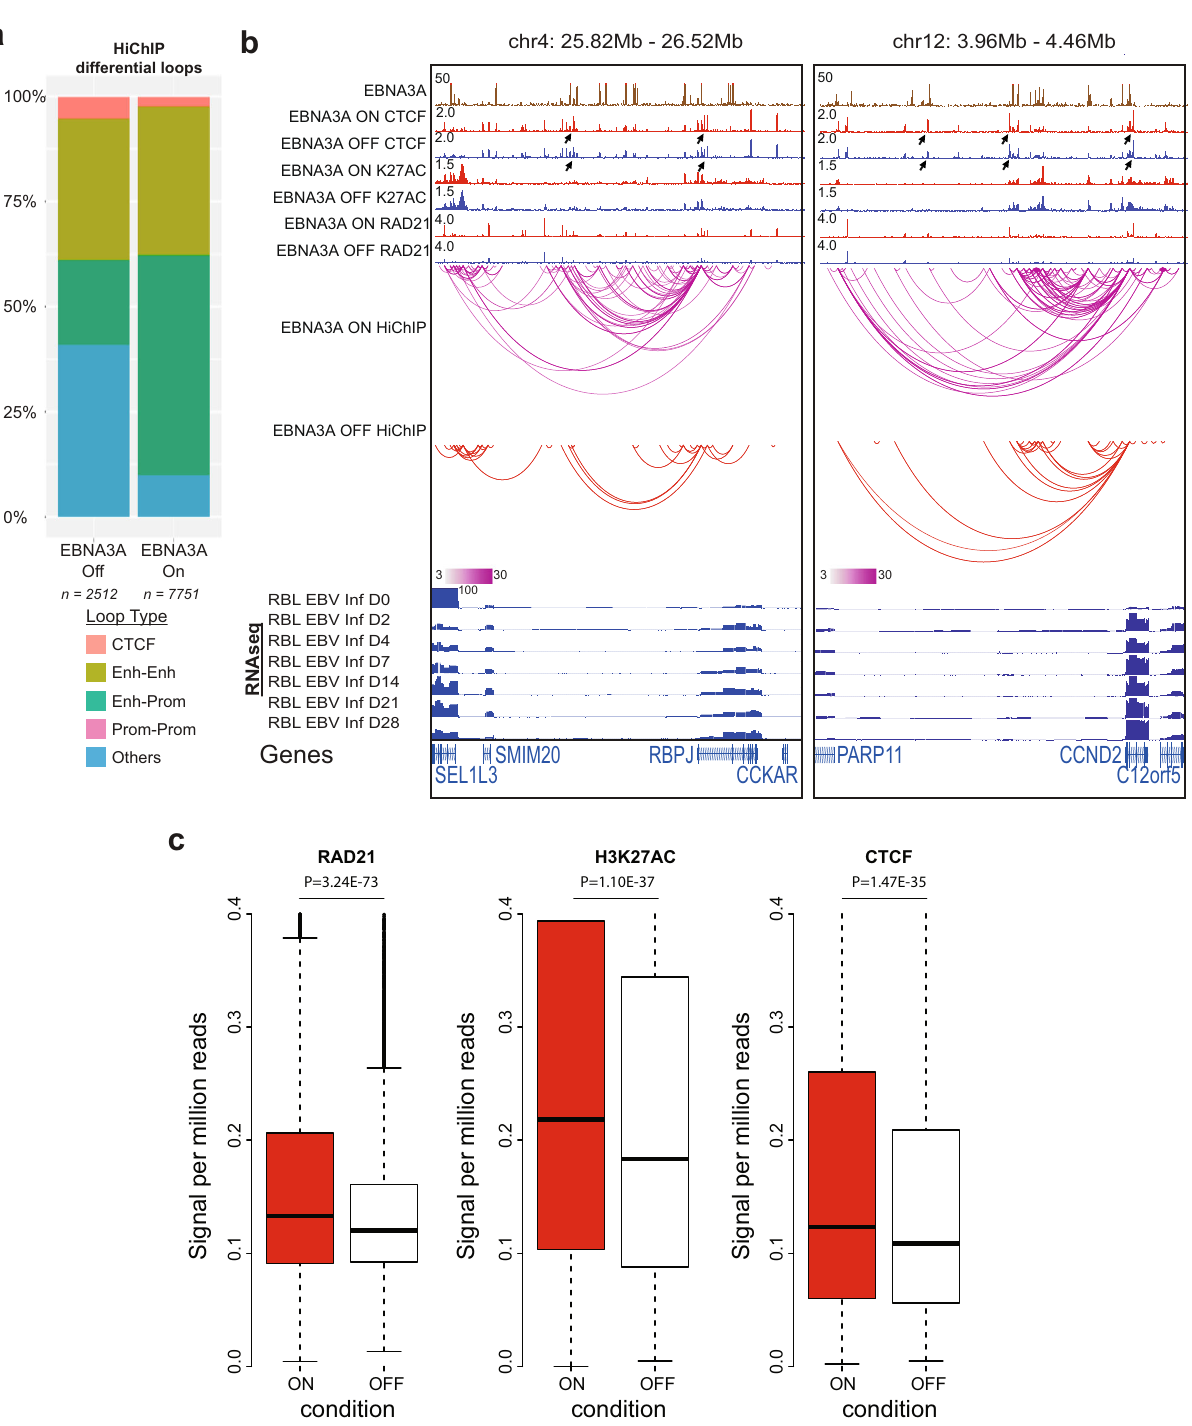
Fig. 5 | EBNA3A induced global changes in chromatin interactions. a H3K27ac HiChIP experiments were used to identify chromatin loops in EBNA3A conditional LCLs grown under permissive (EBNA3A On) or non-permissive (EBNA3A Off) con- ditions. EBNA3A inactivation (EBNA3A Off) resulted in a marked decrease in the numberofloopsformed,decreaseinenhancer-promoterloopsaswellasincreases in CTCF loops and other unannotated loops. All HiChIP loops have FDR<0.01 and p -value <0.05 for differential enrichment between EBNA3A On and Off conditions. b -left Representative genomic tracks on chromosome 4, around the RBPJ gene locus. EBNA3A inactivation resulted in decreased chromatin loops around RBPJ, particularlyatsites with EBNA3A andchromatin looping factors (CTCF,SMC3,and Rad21) present. RNA-seq tracks tracing gene expression throughout the EBV